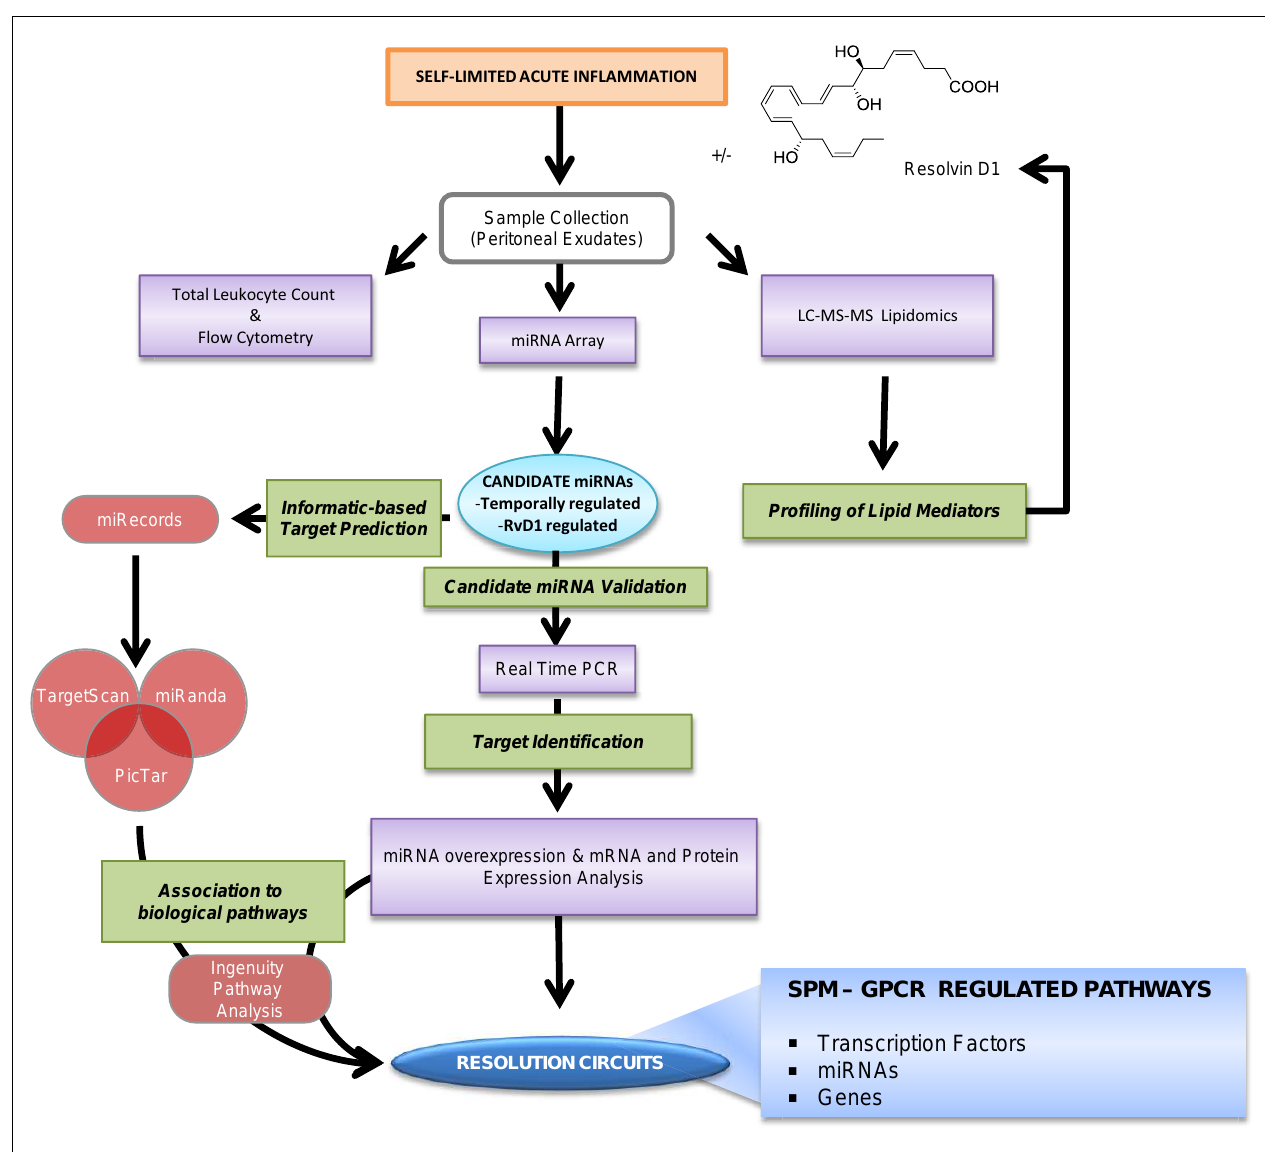
were temporally and/or RvD1-regulated, were confirmed using bioinformatics and prediction of target genes, real-time PCR, as well as overexpression in human M Φ s.The Ingenuity Pathway Analysis Software database was used to identify circuits of molecules and biological functions controlled by RvD1-regulated miRNAs and target genes (see text; Recchiuti et al., 2011 for analysis